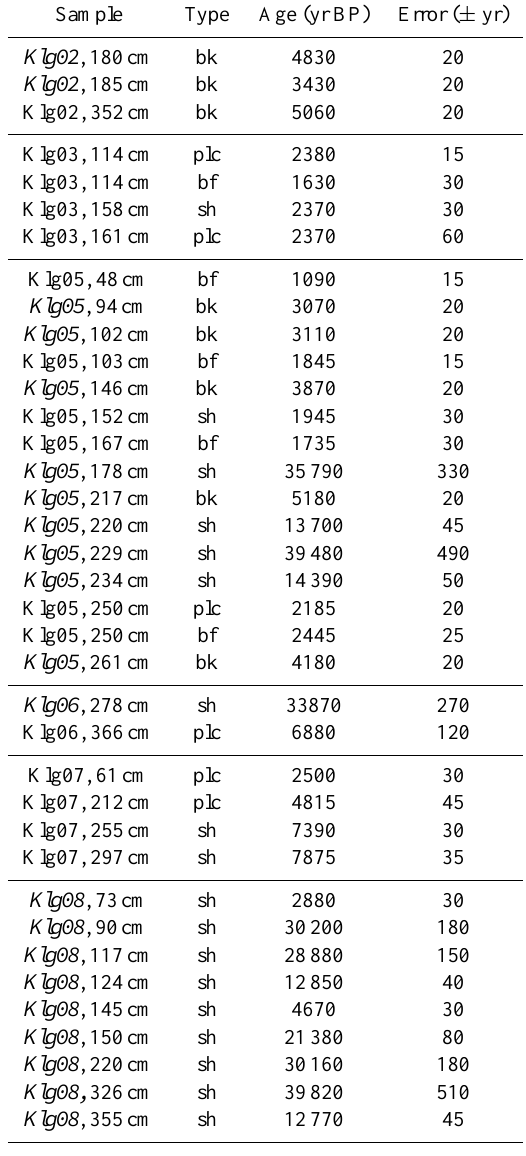
Table 2. AMS radiocarbon dating results performed on bivalve shell fragments (sh), bulk sediment (total organic carbon + total in- organic carbon) (bk), benthic (bf) and planktonic (plc) foraminifers. Sample names written in italics are considered to be reworked and were not used for the data interpretation. Analyses were performed at Artemis LMC14 laboratory and AEON laboratories; 14C dating has not been calibrated and corrected for reservoir